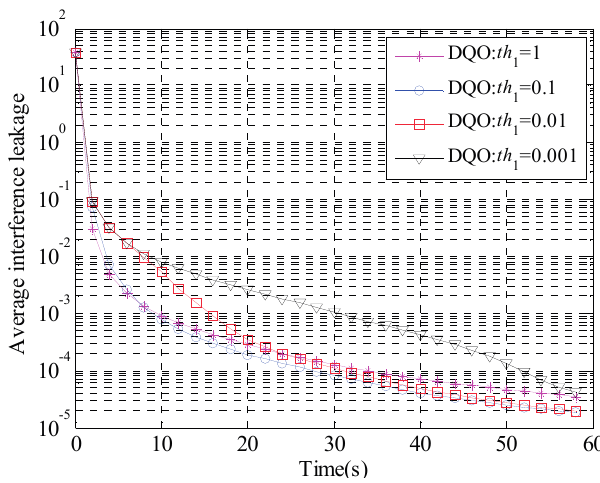
Figure 3. Convergence curves of the average interference leakage of DQO algorithm with th 1 = 1, 0.1, 0.01, and 0.001 in (10 × 10, 1) 19 .